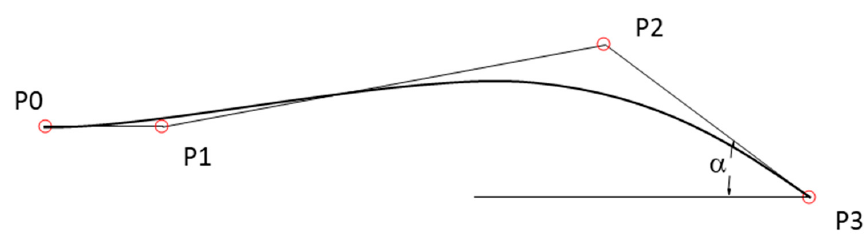
Figure 1. Tangency at the end points of a Bézier curve.